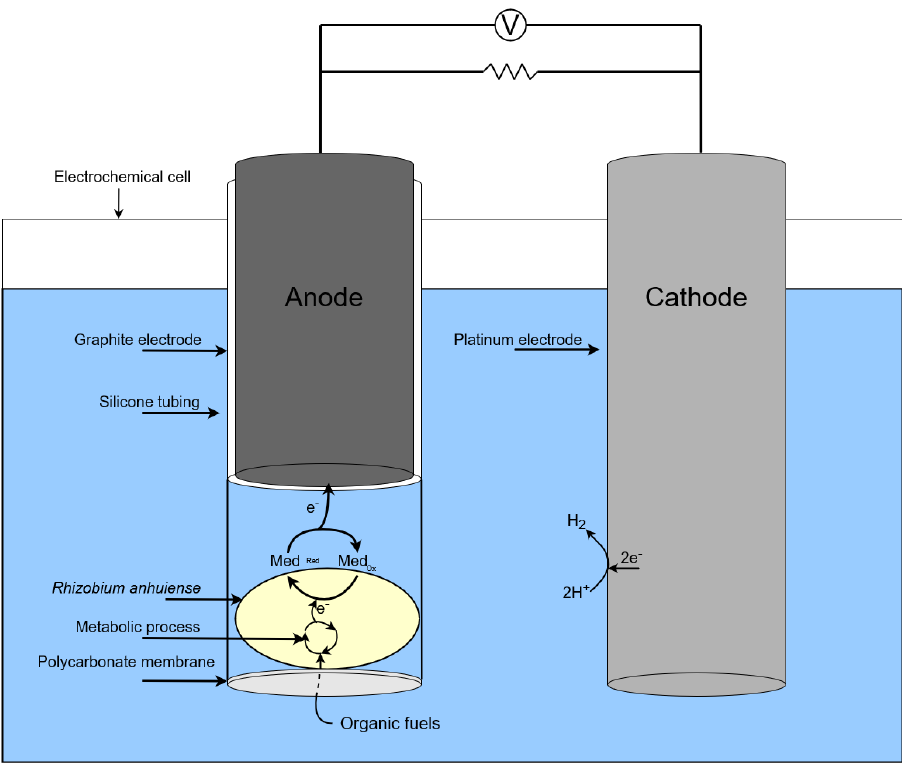
Figure 3. Scheme of a single chamber MFC based on Rhizobium anhuiense .